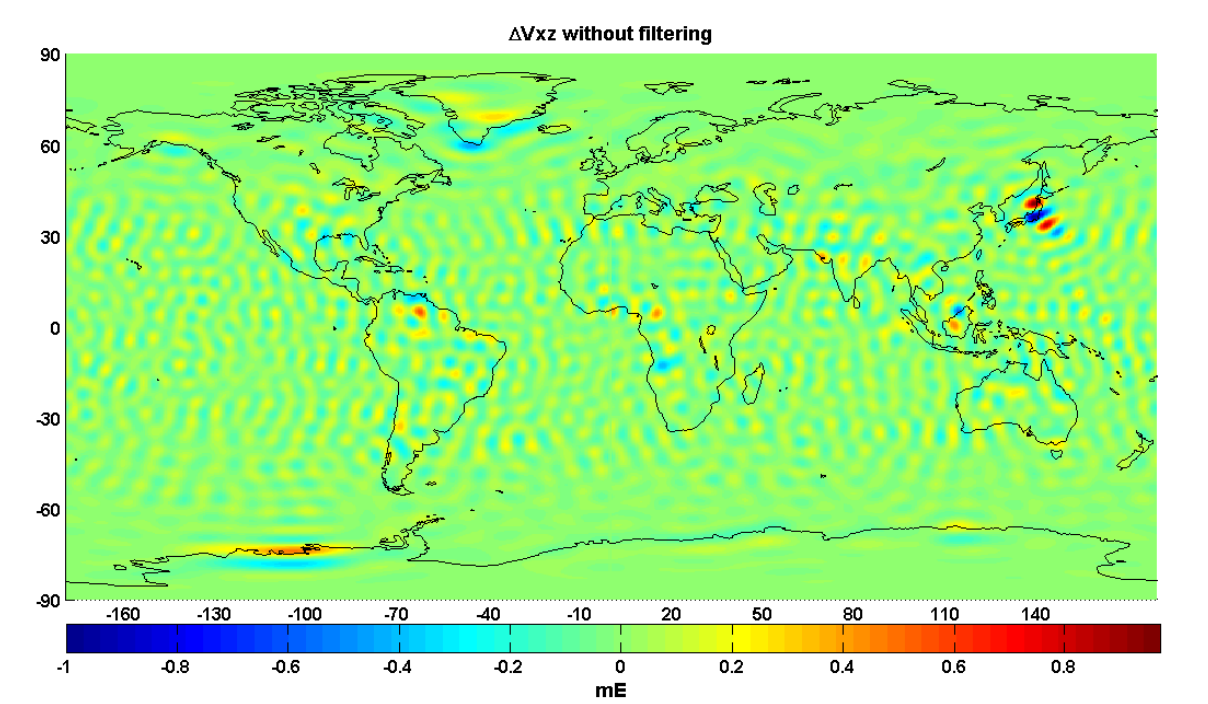
Figure 1. GRACE global ∞ V changes between of 2011 and 2012 and mean of 2009 and 2010 without applying any destriping and spatial xz smoothing filtering procedure (in unit of